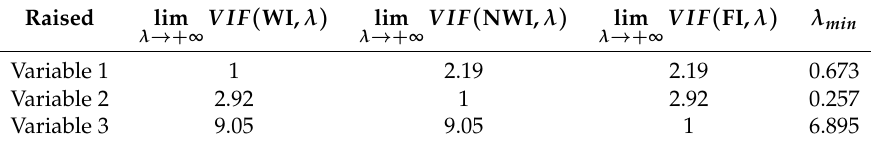
Table 10. Horizontal asymptote for VIFs after raising each variable and λ min